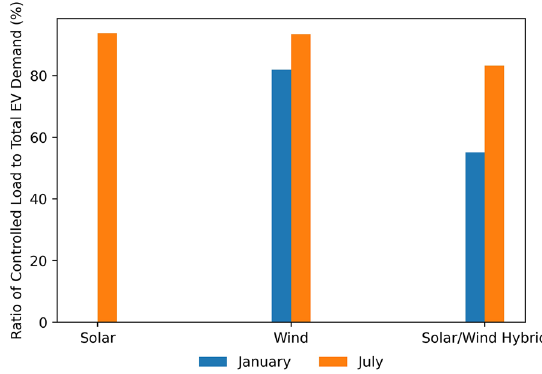
Fig. 8 Ratio of UCC demand to total demand from electric vehicles for solar, wind, and solar/wind configurations. UCC demand is the electric vehicle charging energy shifted to periods of renewable energy